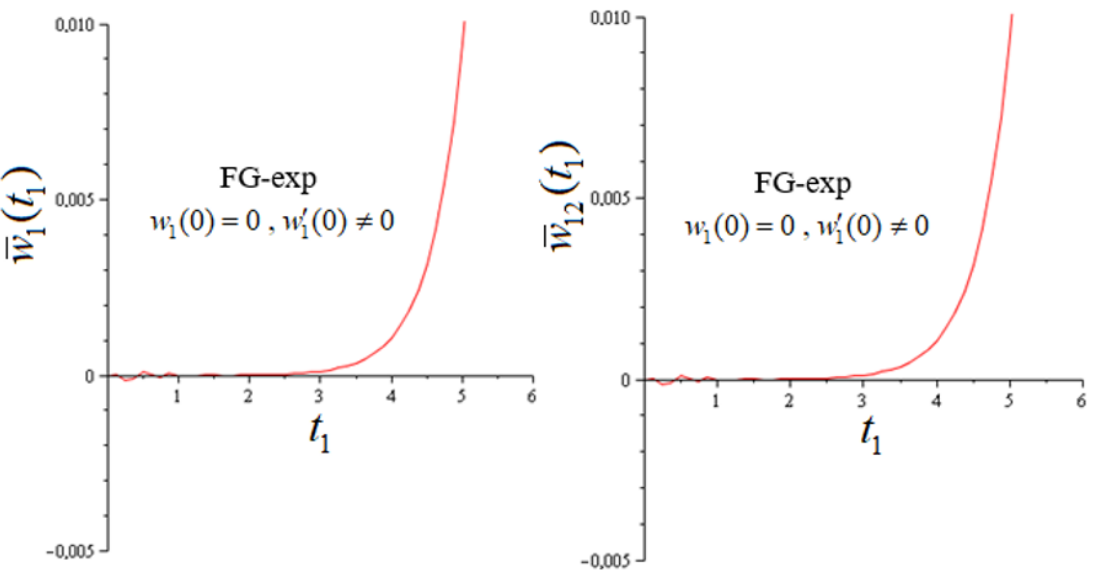
Figure 4. Variation of the deflection of FG-VE-Ps on VE-Fs according to Equation (19) for the initial (0) 0 , (0) 0 w w =  . conditions w conditions ( 0 ) = 0, w (cid:48) ( 0 ) (cid:54) = 1 1 1 1